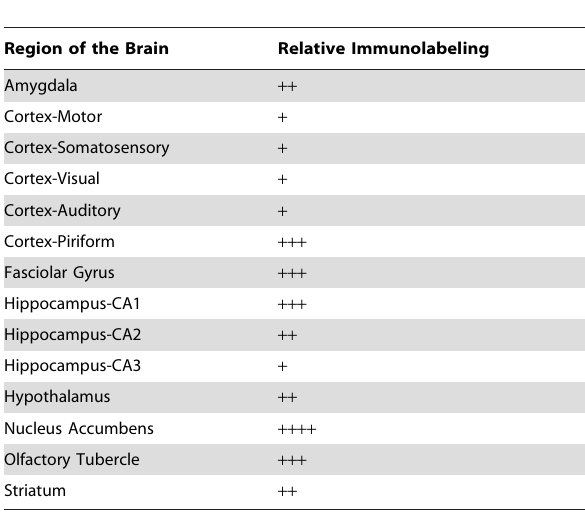
Table 1. Distribution of Mchr1 positive cilia in the mouse